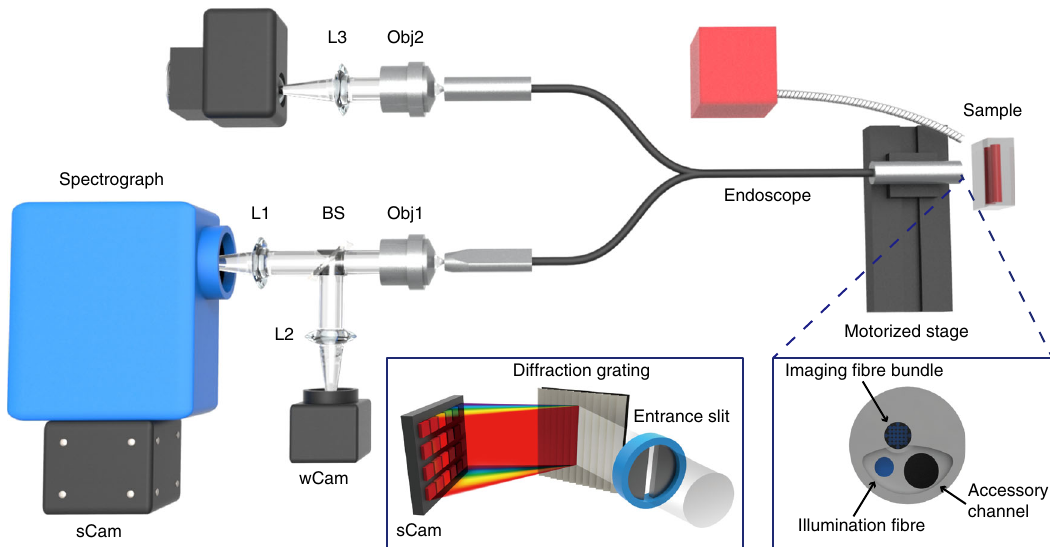
Fig. 1 Optical design of the hyperspectral endoscope. The system is assembled using a clinically approved endoscope with an integrated illumination fi bre, to deliver optical excitation to the sample at the distal end of the endoscope, and an imaging fi bre bundle, to relay image information back to the proximal end of the endoscope. Illumination is provided either by coupling a white LED to the illumination fi bre (internal illumination method), or by directly illuminating a halogen light source to the scene (external illumination method). Line-scan hyperspectral data are acquired using sCam, a CCD coupled to the spectrograph, whereas wide- fi eld image data are acquired using wCam, a monochrome or colour CMOS camera for image registration purposes. Left inset shows the arrangement of the spectrometer and sCam. Right inset shows details of the distal end of the endoscope. CCD charge coupled device, CMOS complementary metal oxide semiconductor, L1 – 3 lens, Obj1 – 2 objective lens, BS beam